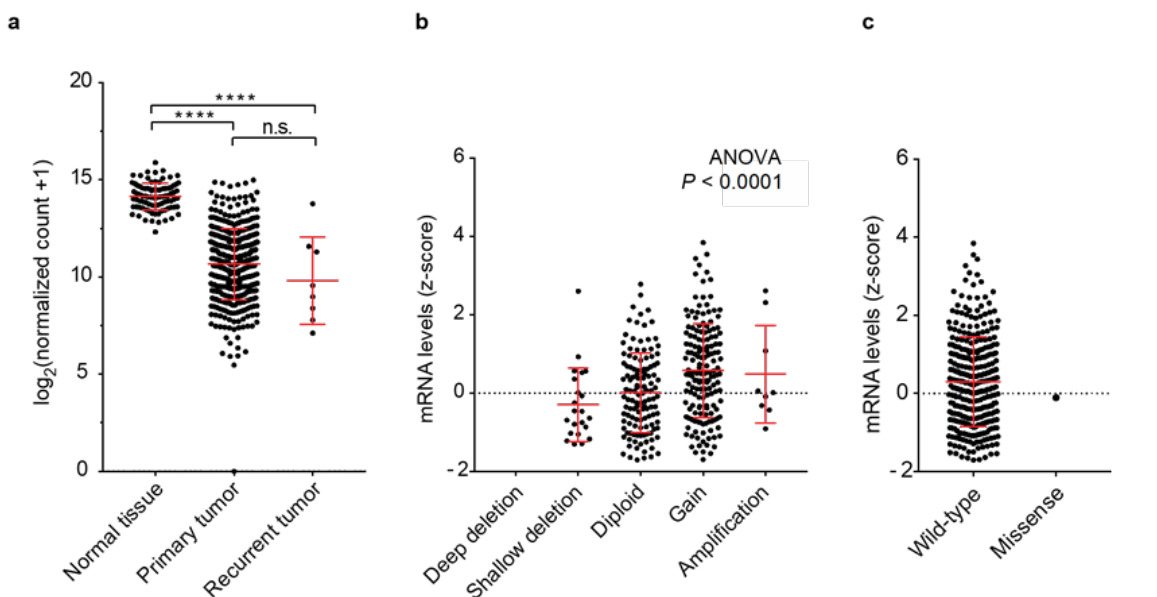
Figure 1. Correlation between PRELP gene expression and genetic mutation and copy number alteration (CNA) in ovarian cancer. ( a ) PRELP mRNA expression (y-axis) is plotted against normal tissue ( n = 88), primary tumor ( n = 419), recurrent tumor ( n = 8). Statistical analysis was performed using Student’s t -test. **** p < 0.0001, n.s.: not significant. ( b ) PRELP mRNA expression (z-scores relative to diploid samples (y-axis) is plotted against CNAs in the PRELP gene ( n = 316). Shallow deletion (CNA = − 1), diploid (CNA = 0), gain (CNA = +1), and amplification (CNA = +2) are shown. ( c ) PRELP mRNA expression (z-scores relative to diploid samples; y-axis) is plotted against a wild-type ( n = 315) or missense mutation ( n = 1; x-axis).